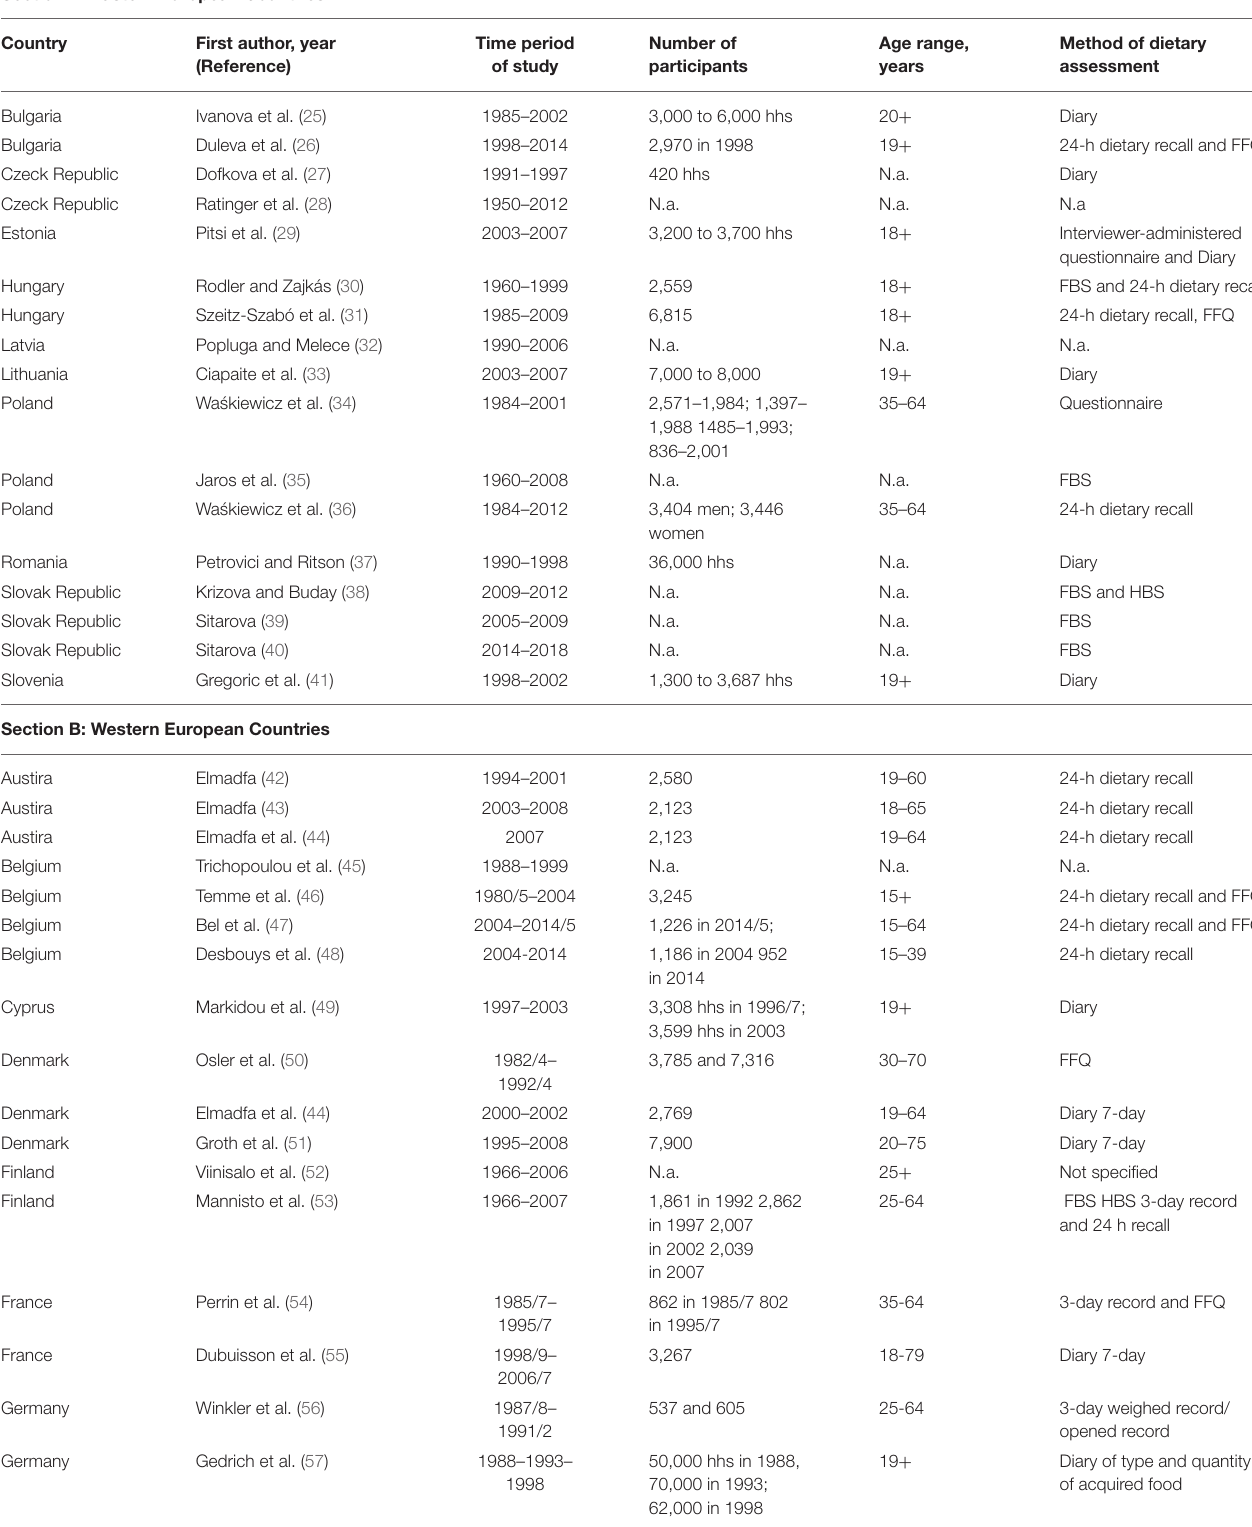
TABLE 1 | Summary of studies included in the